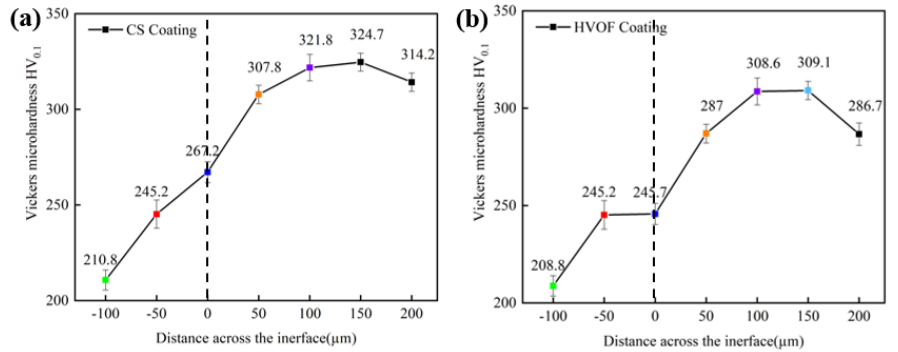
Figure 6. Microhardness–depth curves of high-entropy alloy coatings. ( a ) CS coating; ( b ) HOVF coating.